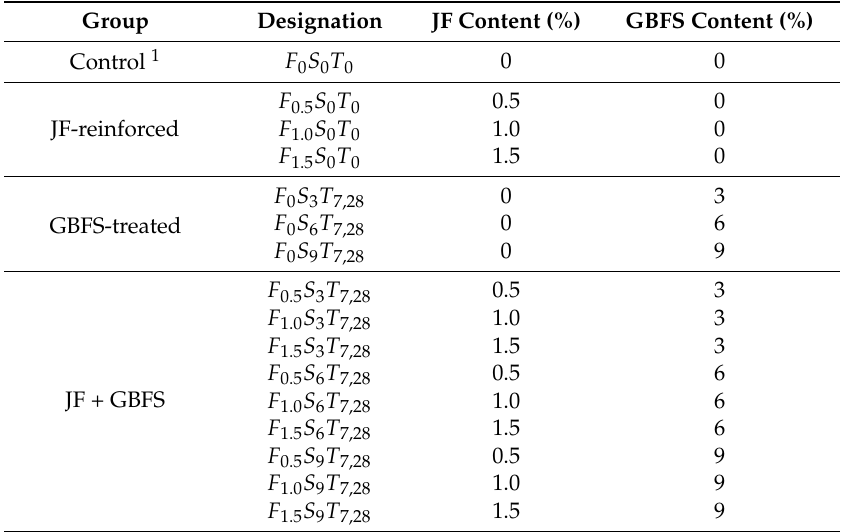
Table 5. Mix designs and their